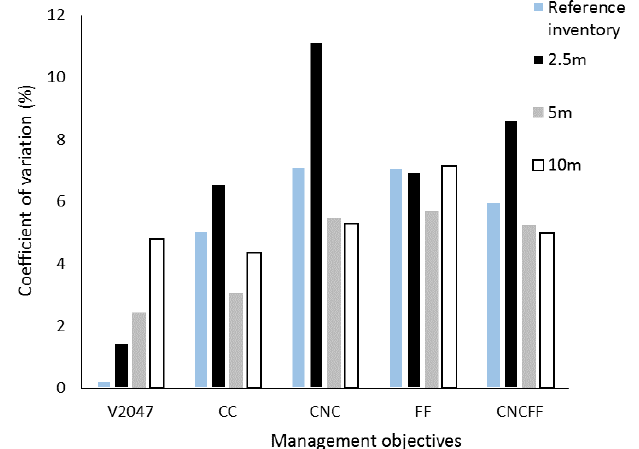
Figure 5. Variation (standard deviation divided by mean) of the achieved values of management objectives in the 10 optimizations based on the Reference inventory and in the 20 optimizations for each level of positioning error (standard deviations of 2.5, 5 and 10 m). The assessed management objectives were V 2047 (standing volume at the end of the plan), CC (proportion of shared boundary between treated cells), CC FF (same as CC but specifically for cells prescribed as final felling), CNC (proportion of shared boundary between treated and non-treated cells), CNC FF (same as CNC but specifically for cells prescribed as final felling).